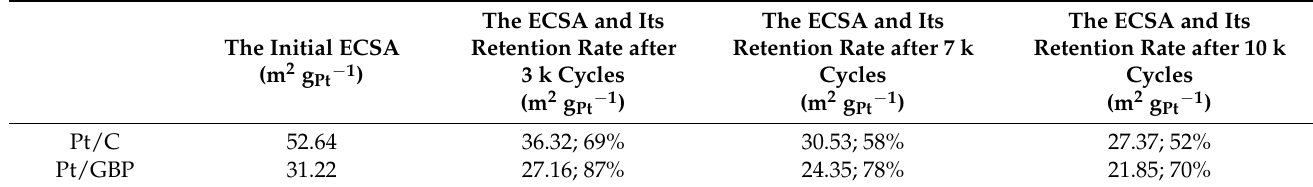
Table 6. The ECSA retention rate of Pt/C and Pt/GBP during 30 k cycles (1.0–1.5